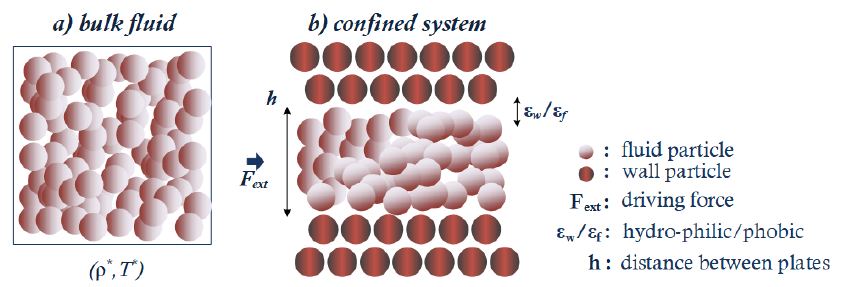
Figure 4. The datasets to investigate the ML algorithms refer to ( a ) a bulk LJ fluid system, with density and temperature parameters as inputs, and ( b ) a confined Poiseuille flow model.